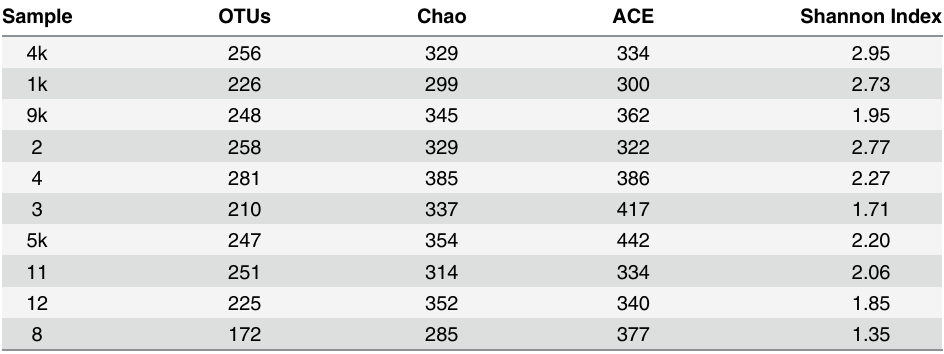
Table 1. Richness and diversity indexes of bacterial community from deep caries samples